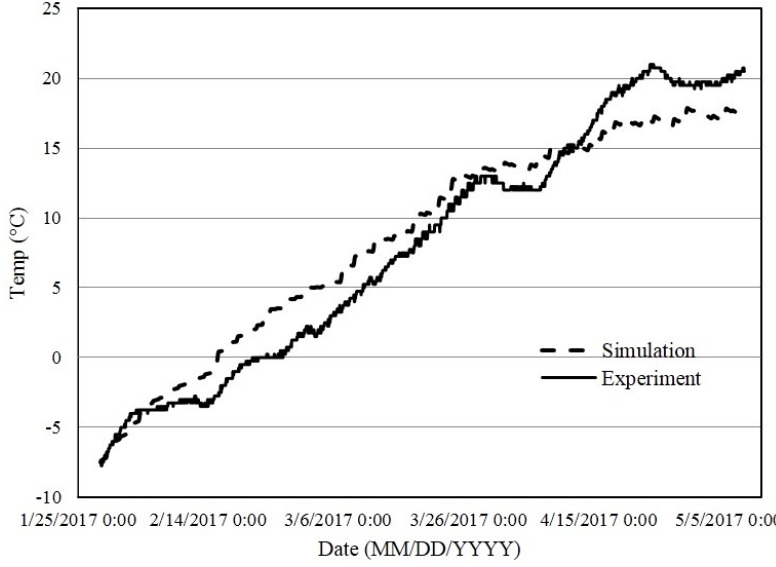
Figure 14. Simulated sand ‐ bed temperature over time.